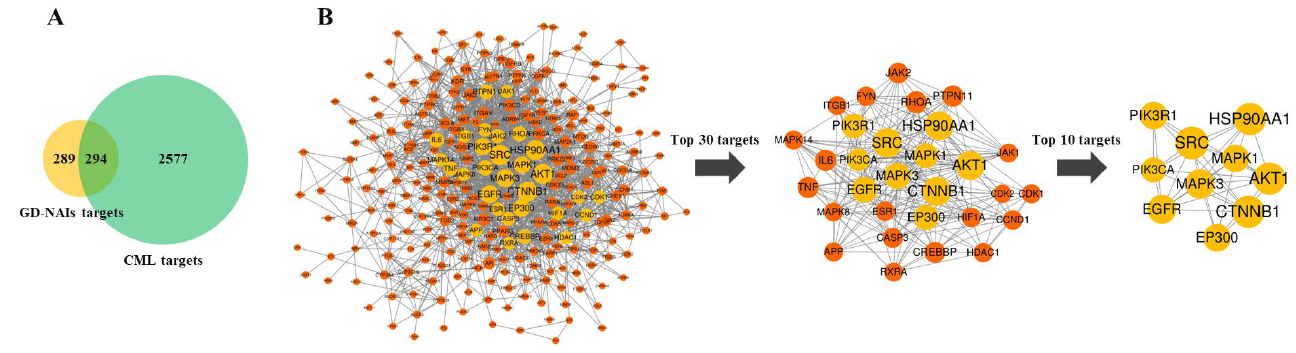
Figure 4. ( A ) The Venn diagram of the intersection of GD-NAIs targets and CML targets. ( B ) Pro- tein–protein interaction (PPI) network of targets of GD-NAIs against CML.